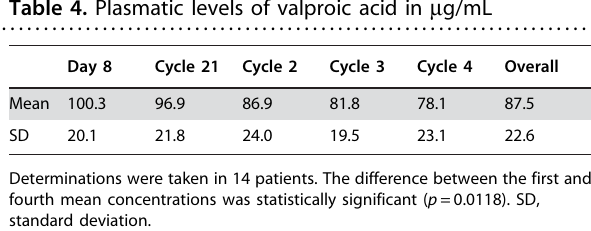
Table 4. Plasmatic levels of valproic acid in m g/mL .. ... .... ... ... .... ... ... .... ... ... .... ... ... .... ... ... .... ... ... .... .